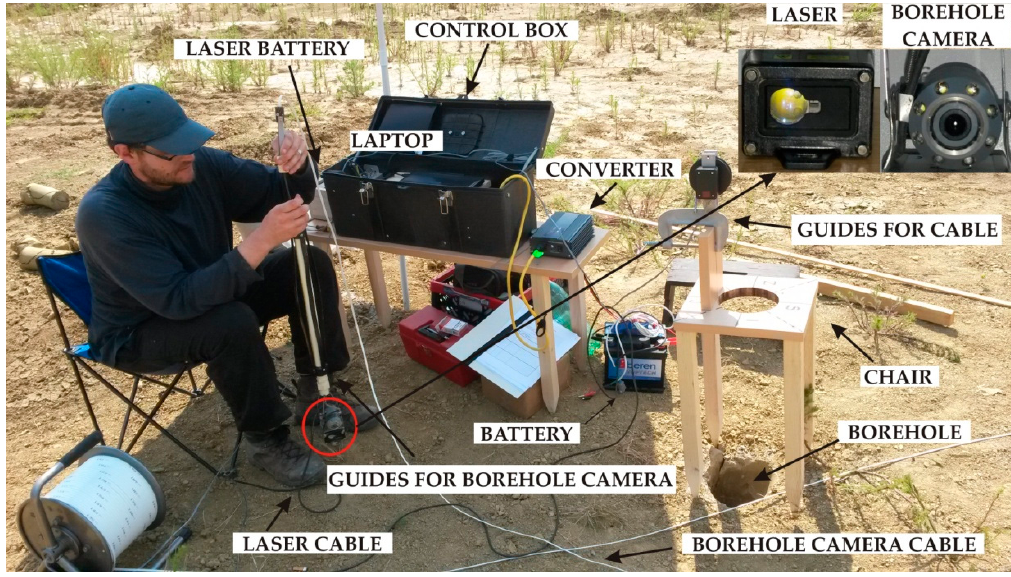
Figure 5. Spherical expansion measurement equipment [14].